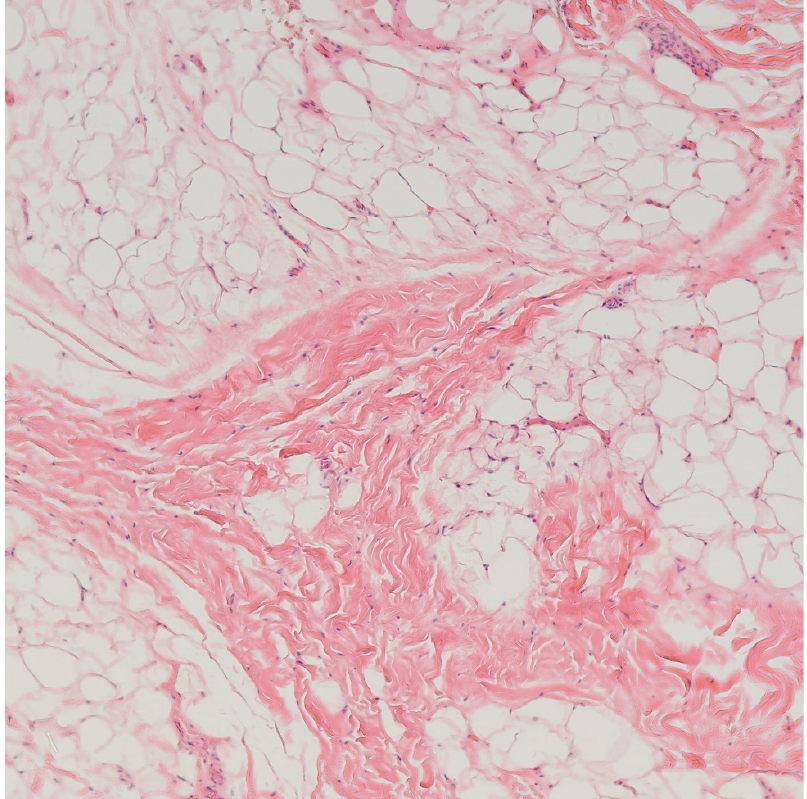
Figure 3. Microscopic images showing that the mass predominantly consisted of mature adipose tissue with thin and thick, irregular fibrous septae (Hematoxylin & eosin,